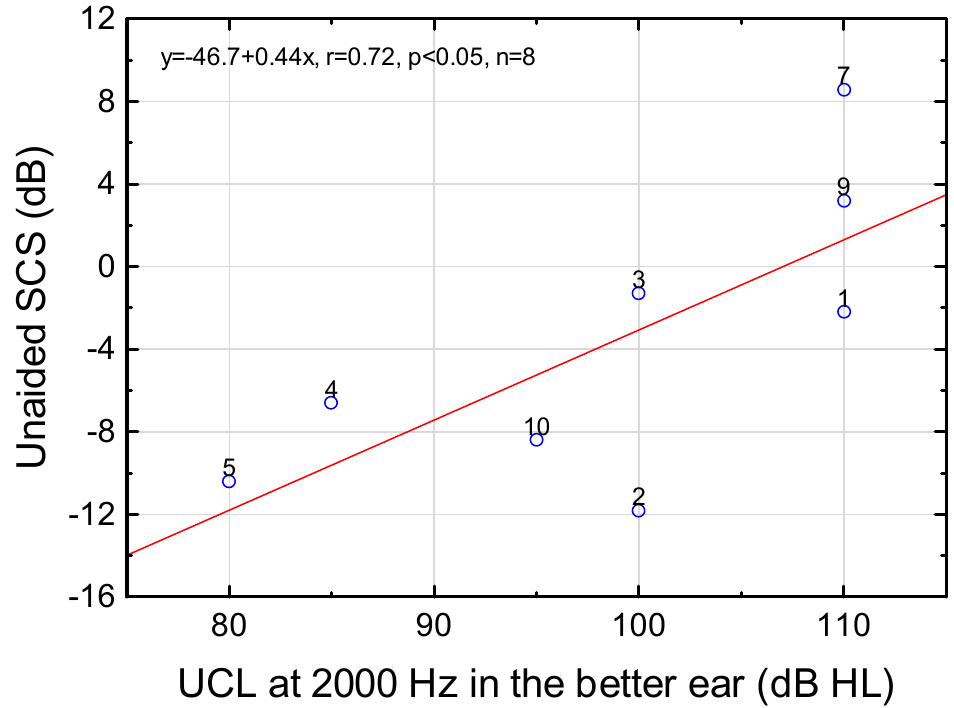
Figure 6. Unaided recognition of speech in competing speech (SCS) as a function of uncomfortable loudness level for pure tones (UCL) at 2000 Hz in the better ear for all the subjects who revealed UCLs within the measurable range (r = 0.72, p = 0.046, n = 8).